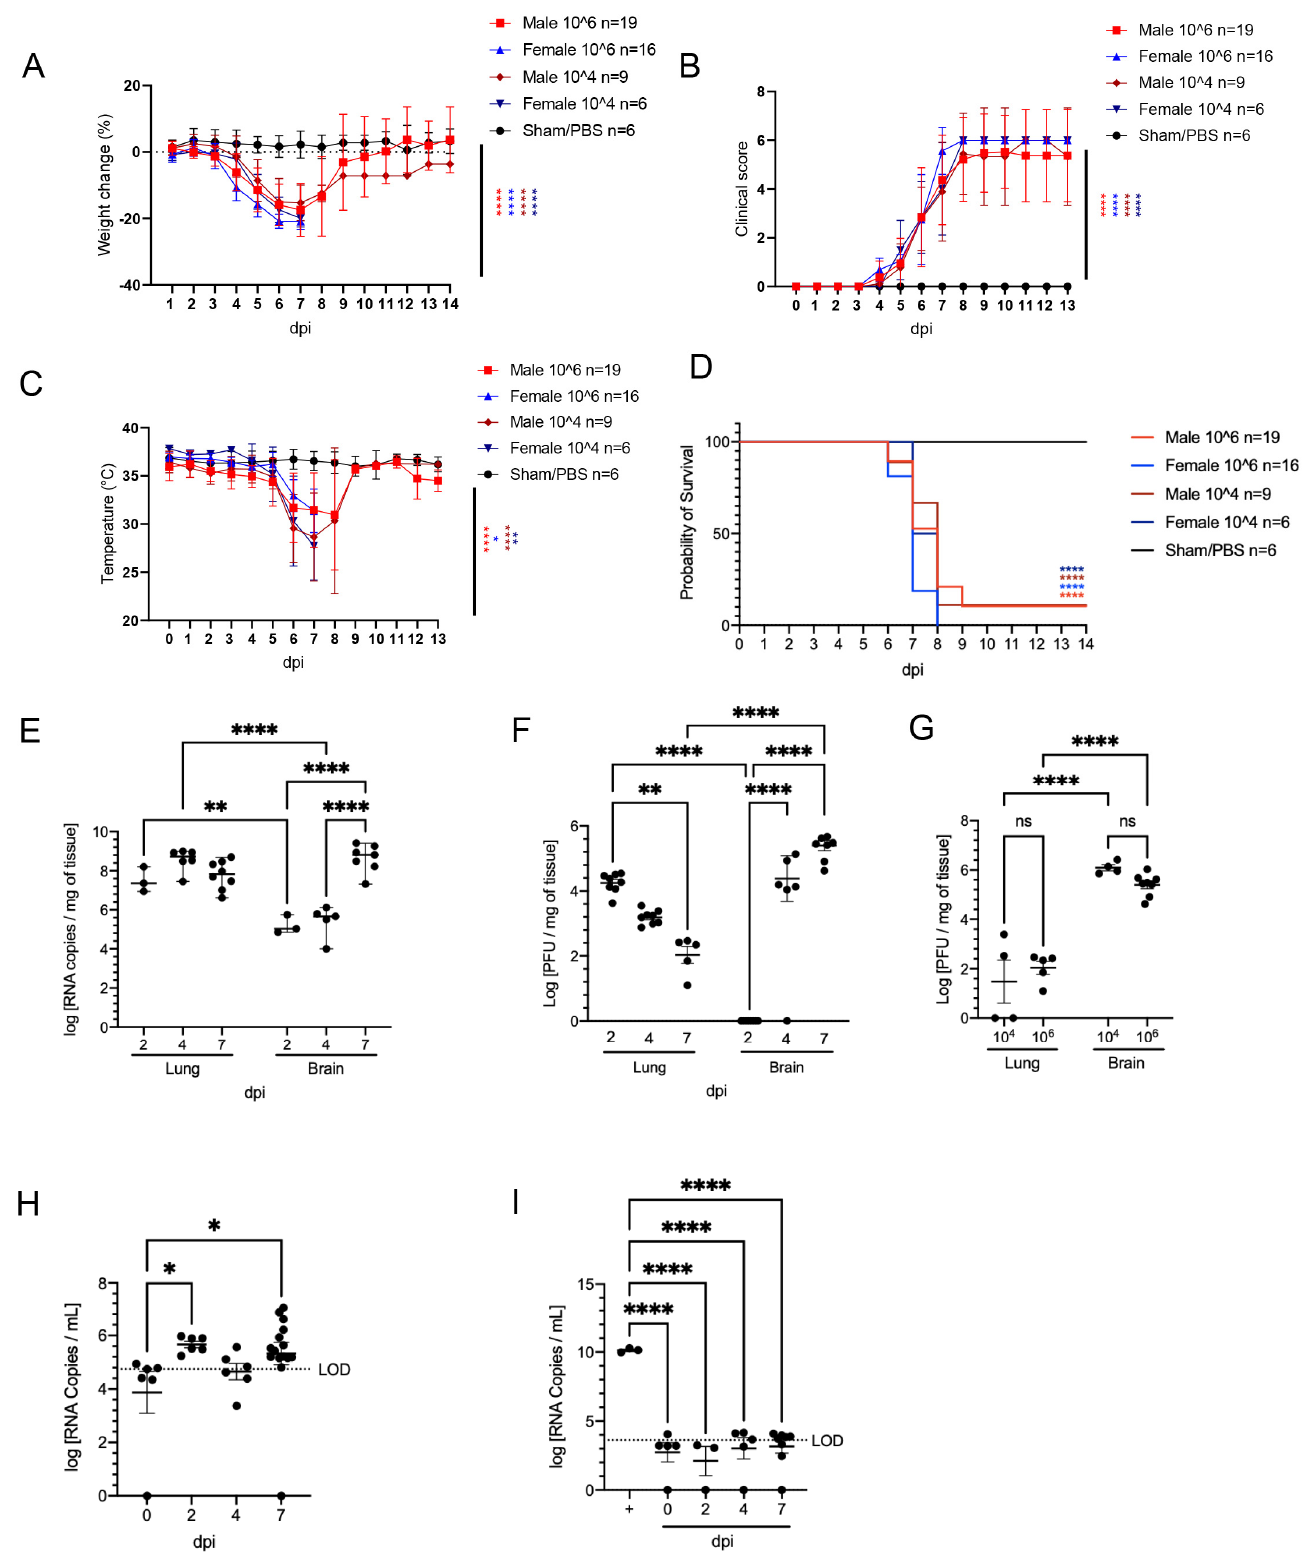
Figure 1. SARS-CoV-2 caused lethal disease in K18-hACE2 mice irrespective of dose (10 4 vs. 10 6 PFU). K18-hACE2 mice (n = 50) were inoculated intranasally with either 1 × 10 4 or 1 × 10 6 plaque forming units (PFU), with n = 6 additional Sham/PBS negative controls. Body weight ( A ), clinical signs ( B ), body temperature ( C ), and survival ( D ) were monitored daily in Sham/PBS animals (black) and